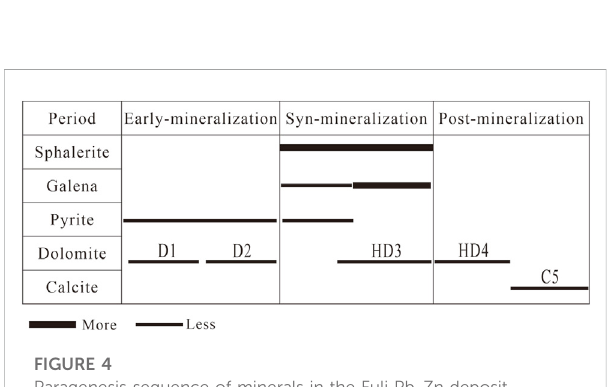
FIGURE 4 Paragenesis sequence of minerals in the Fuli Pb-Zn